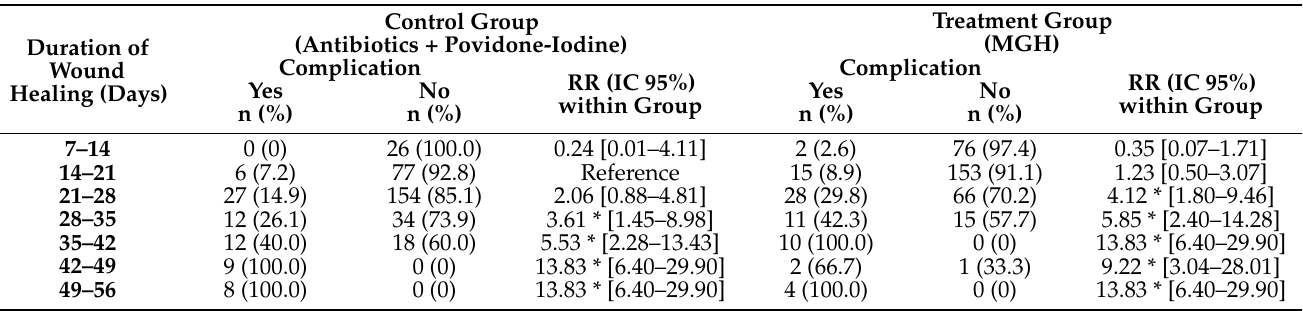
Table 7. Overview of wound healing time per study group. Both the control and treatment groups consisted of 383 patients, with 74 and 72 patients considered to have postoperative complications, respectively. Subgroups were based on the presence or absence of postoperative complications. * represents a significant difference ( p <